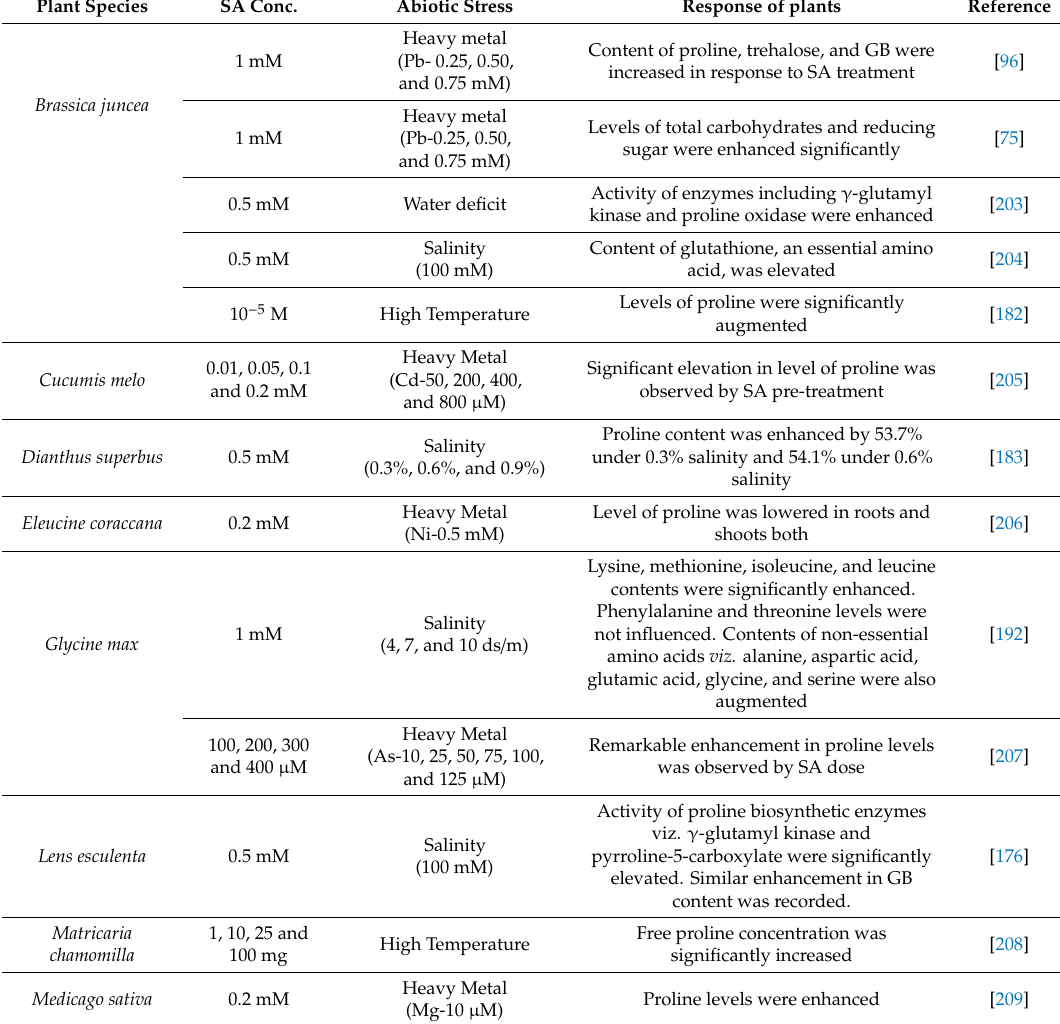
Table 1. SA-influenced alterations in osmolyte content in plants exposed to abiotic stresses. Plant